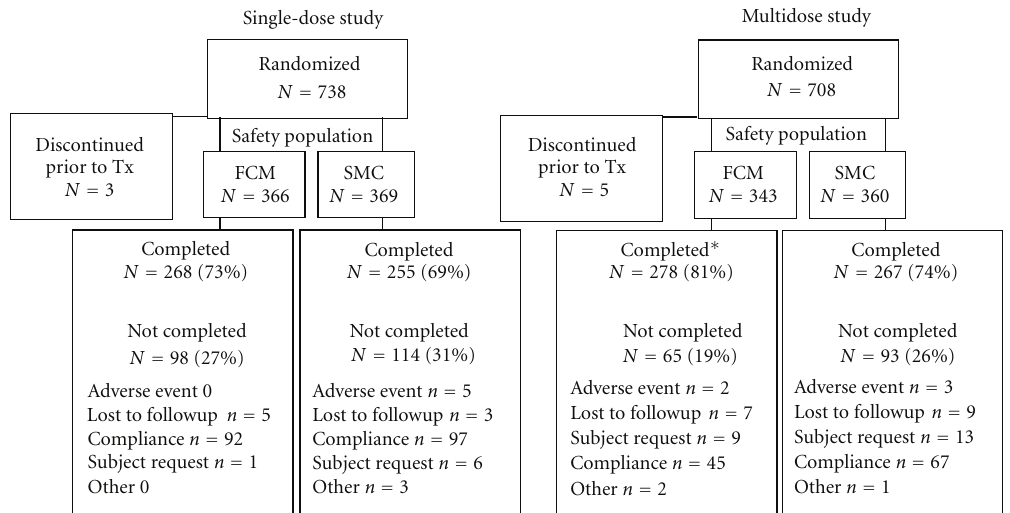
Figure 1: Disposition of subjects in the single-dose and multidose